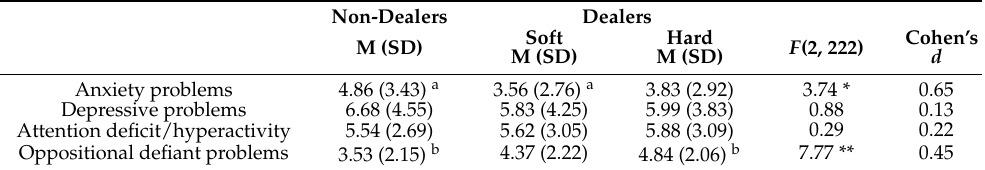
Table 8. Mental Health Problems Among Non-Dealers ( N = 79), Soft-Drug Dealers ( N = 63) and Hard-Drug Dealers ( N =